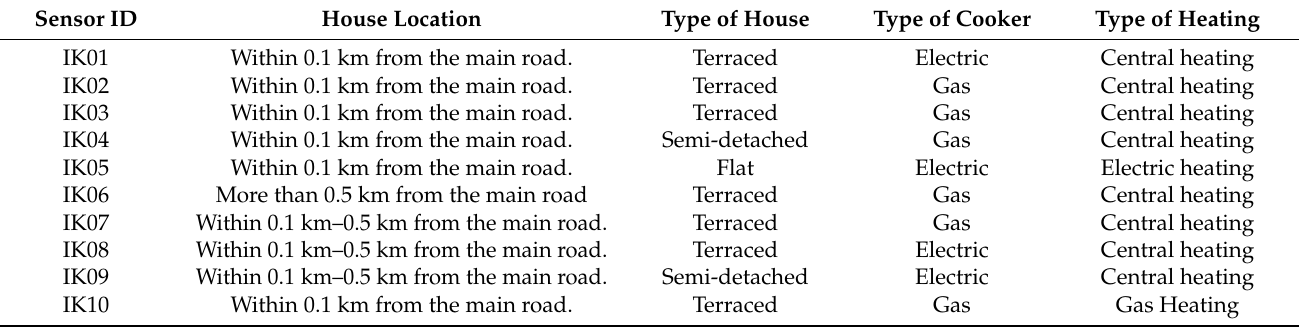
Table 2. Summary of initial questionnaires outcome of participant’s demographic information for study